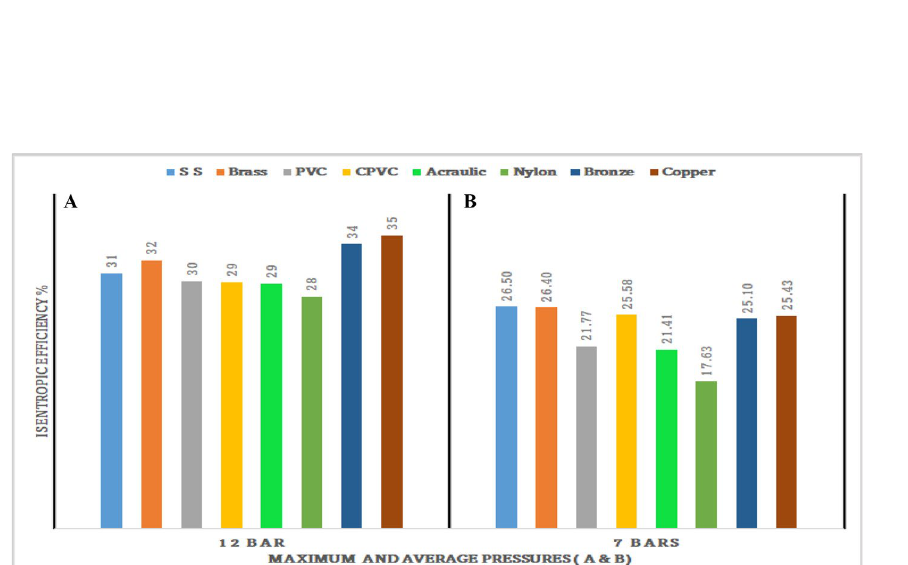
Figure 75. Maximum and average pressure versus isentropic efficiencies (η Isen